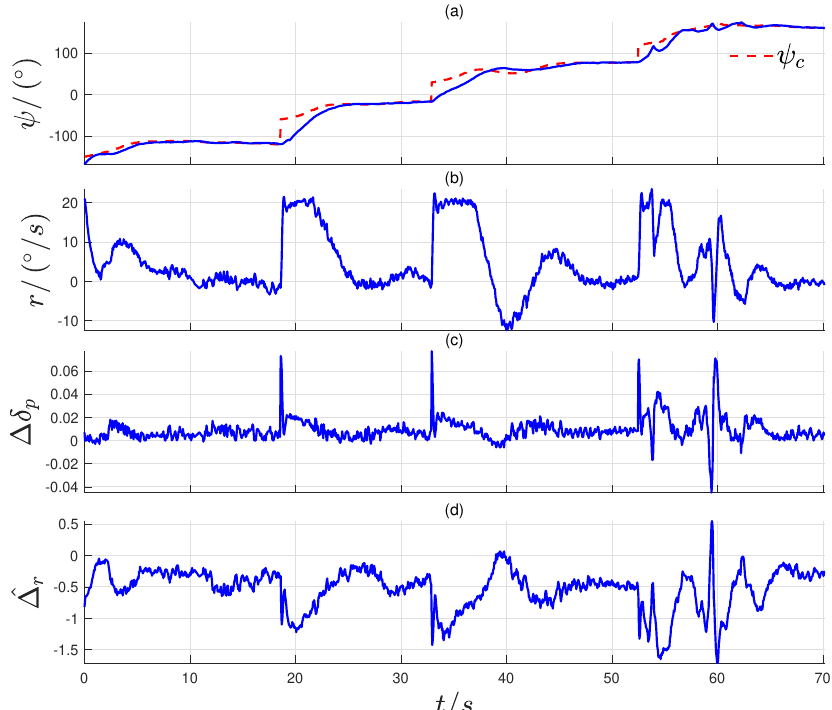
Figure 17. The yaw angle ( a ), yaw angular rate ( b ), differential propeller thrust ( c ) and observer ( d ) curves during the